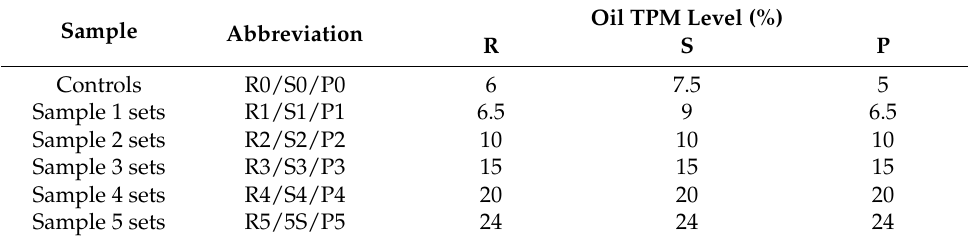
Table 1. Description of soap sample abbreviations and corresponding oil TPM%